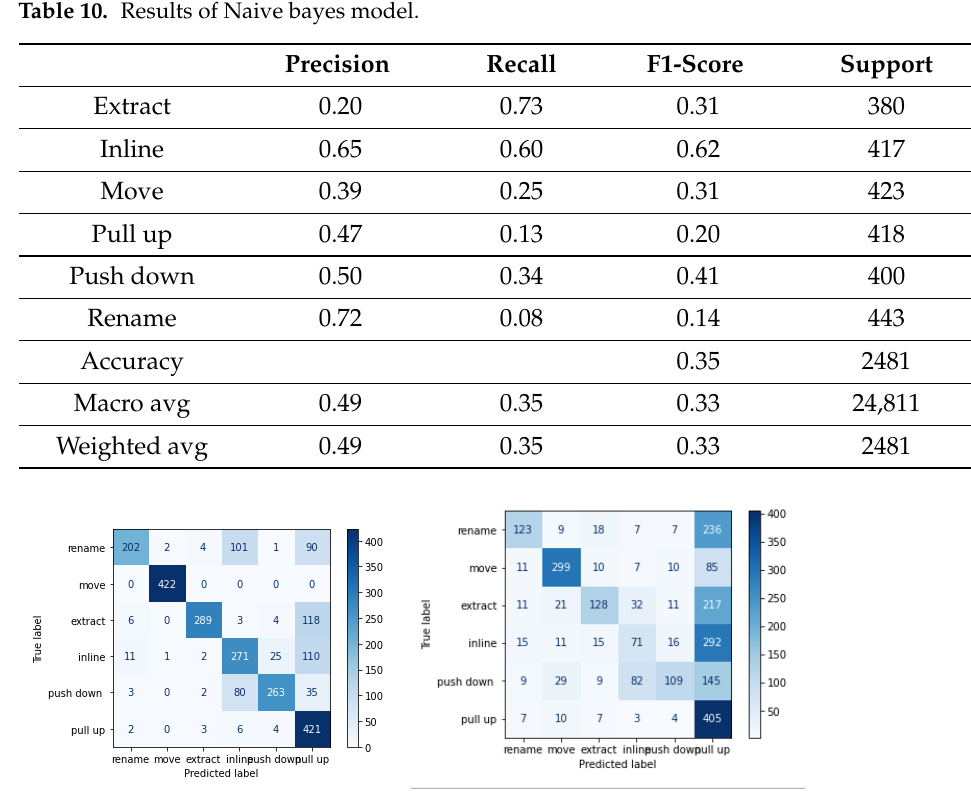
Figure 5. Confusion Matrix for random forest classifier and SVM (Metrics only).